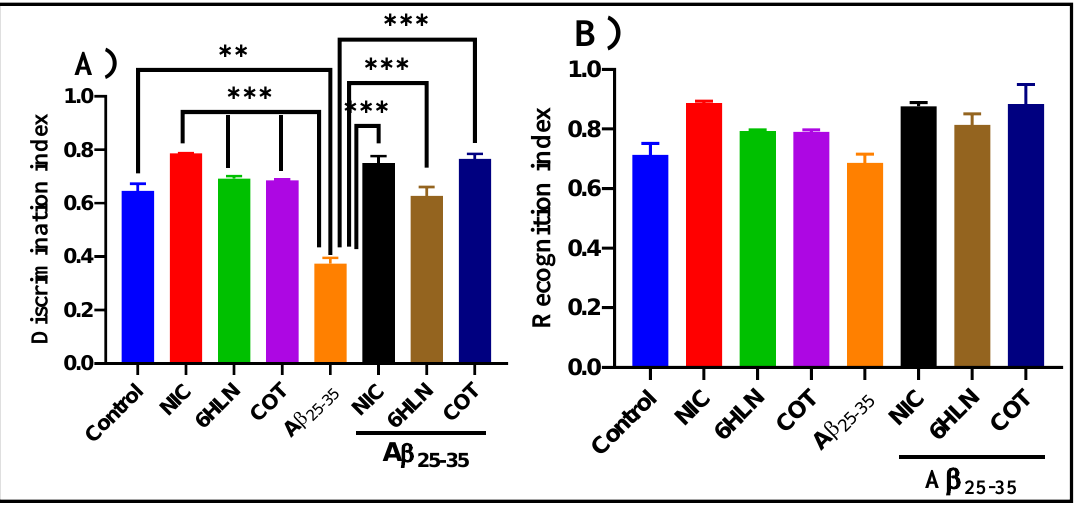
Figure 5. Effects of NIC, 6HLN and COT (0.3 mg/kg, b.w., i.p.) administration in Aβ 25-35 -treated rats on ( A ) discrimination and ( B ) recognition indices within NOR task. Values are expressed as means ± S.E.M. ( n = 6 animals per group). ANOVA analysis revealed overall significant differences between groups in ( A ) F(4,10) = 37.45, p < 0.0001. For Tukey post hoc analyses–( A ) ** Control vs. Aβ 25-35 : p < 0.01; *** NIC vs. Aβ 25-35 , 6HLN vs. Aβ 25-35 , COT vs. Aβ 25-35 , Aβ 25-35 vs. NIC + Aβ 25-35 , Aβ 25-35 vs. 6HLN + Aβ 25-35 , Aβ 25-35 + COT + Aβ 25-35 : p < 0.0001.